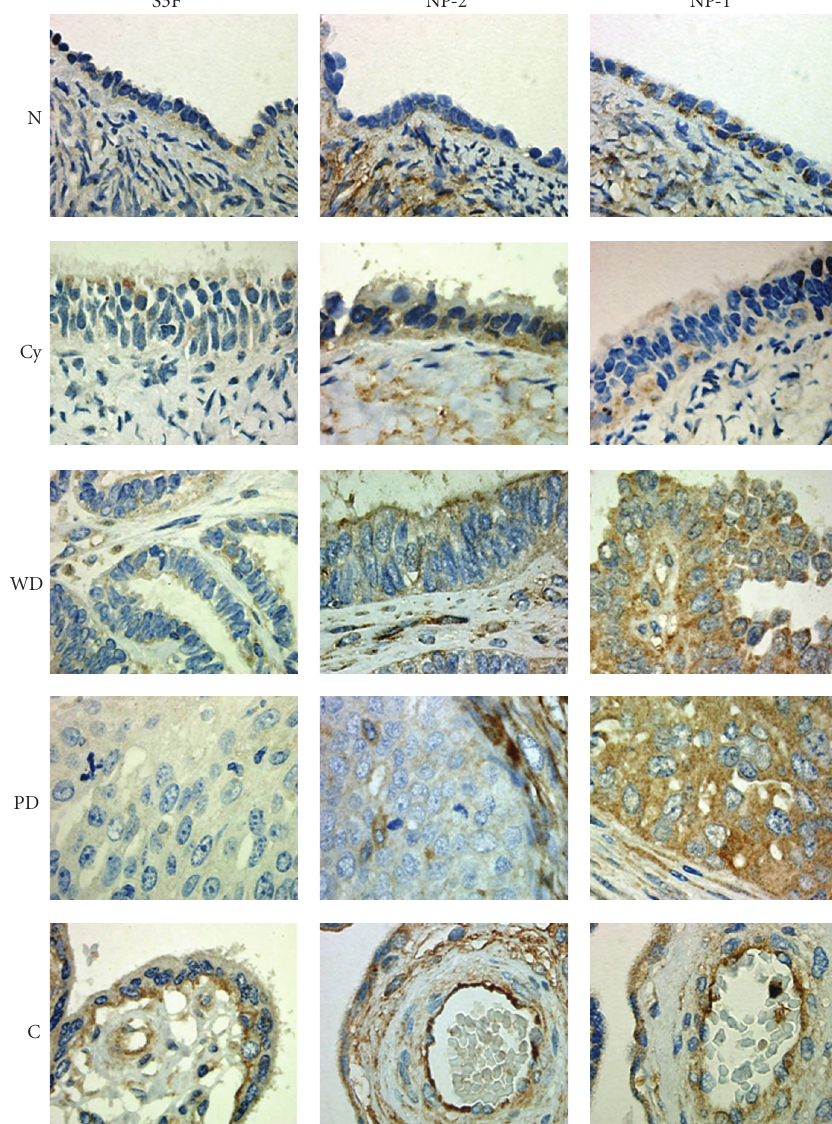
Figure 1: S3F expression decreases while NP-1 increases with epithelial ovarian cancer progression. Representative illustrations of immunohistochemical staining of normal (N), serous cystadenoma (Cy), well-di ff erentiated (WD) and poorly di ff erentiated (PD) serous adenocarcinomas) for S3F, NP-2, and NP-1. Placental tissue was used for positive control (C) and arrow indicates expression of S3F by endothelial cells. Primary antibodies were replaced with non-immune serum in negative control sections (inset). Original magnification: 400 ×